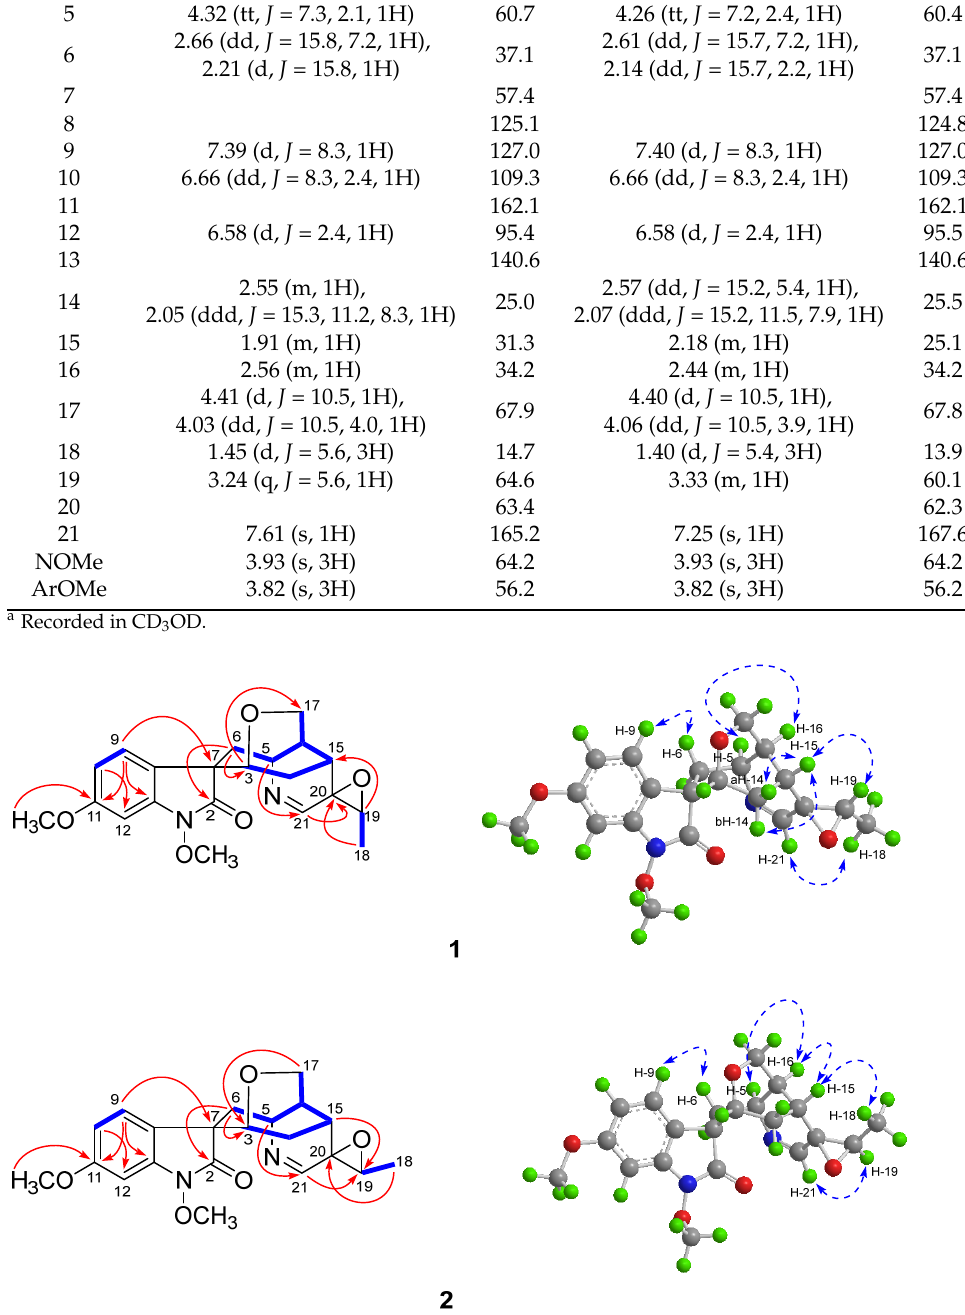
Figure 3. Calculated interproton distances near the epoxide for the two possible structures ( 1A and 1B ) of compound 1 .